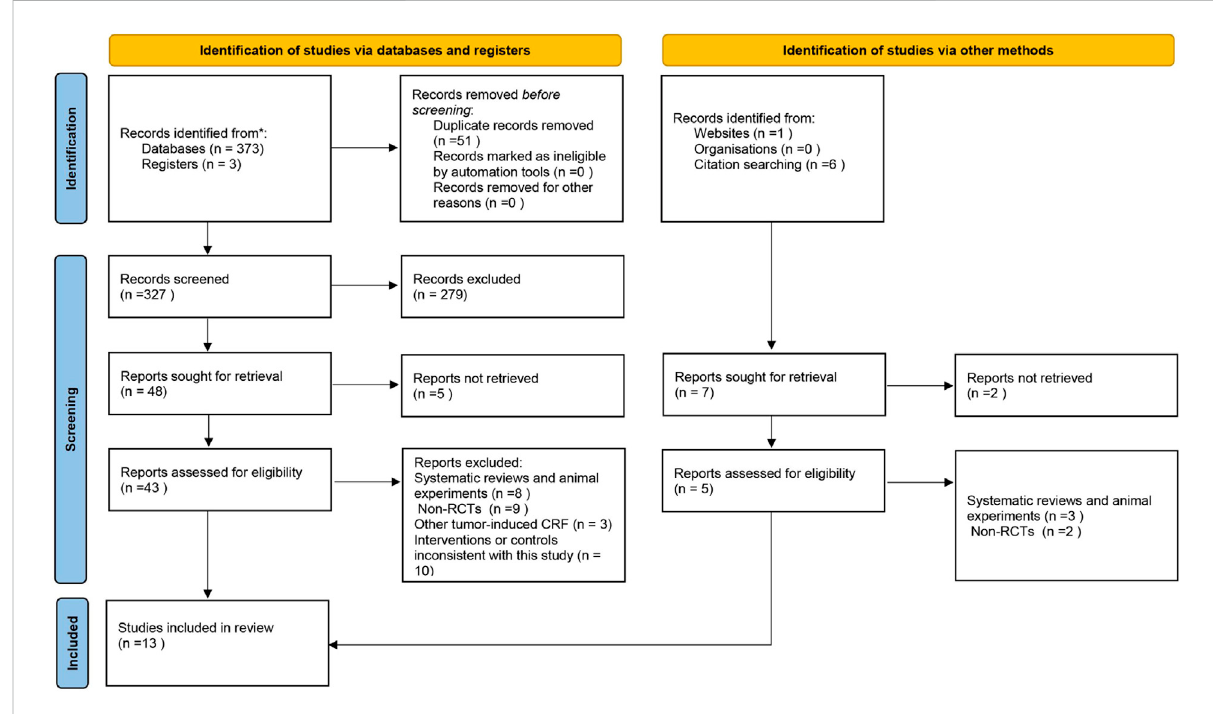
FIGURE 1 A prisma fl ow diagram of the literature screening and selection